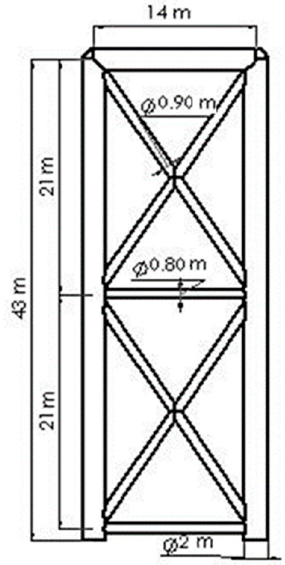
Figure 1. Schematic drawing of a jacket-type structure installed with oscillating water column (OWC) converter.